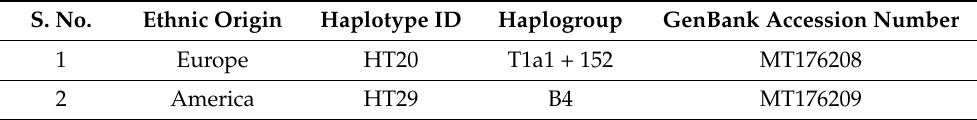
Table 1. mtDNA sequence variation and geographical distribution of mtDNA in sickle cell patients. S.